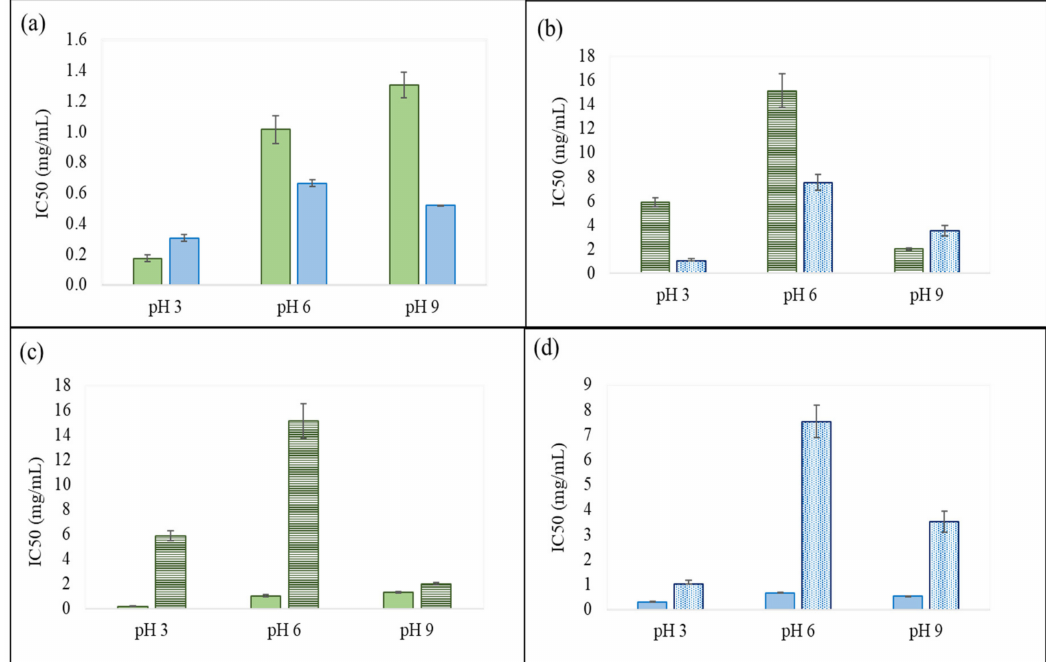
Figure 2. Comparison of 50% radical inhibition by the propolis extracts: ( a ) ethanol (green bar) and water (blue bar), ( b ) polyethylene glycol (PEG)-400 in ethanol (green line bar) and PEG-400 in water (blue dot bar), ( c ) ethanol (green bar) and PEG-400 in ethanol (green line bar), and ( d ) water (blue bar) and PEG-400 in water (blue dot bar) at di ff erent pH